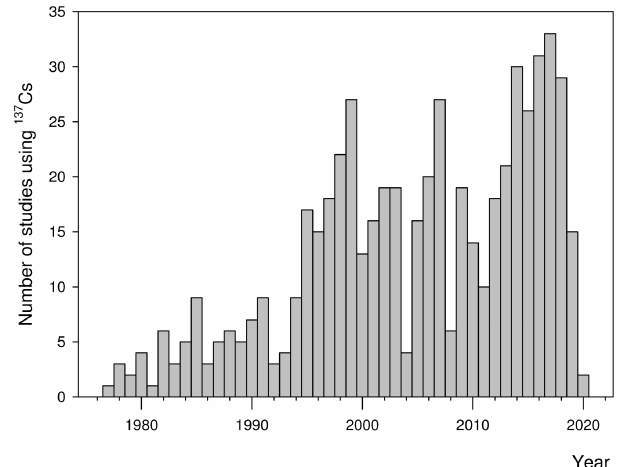
Figure 2. Evolution of the number of studies using 137 Cs for dating sediment sequences between 1977 and